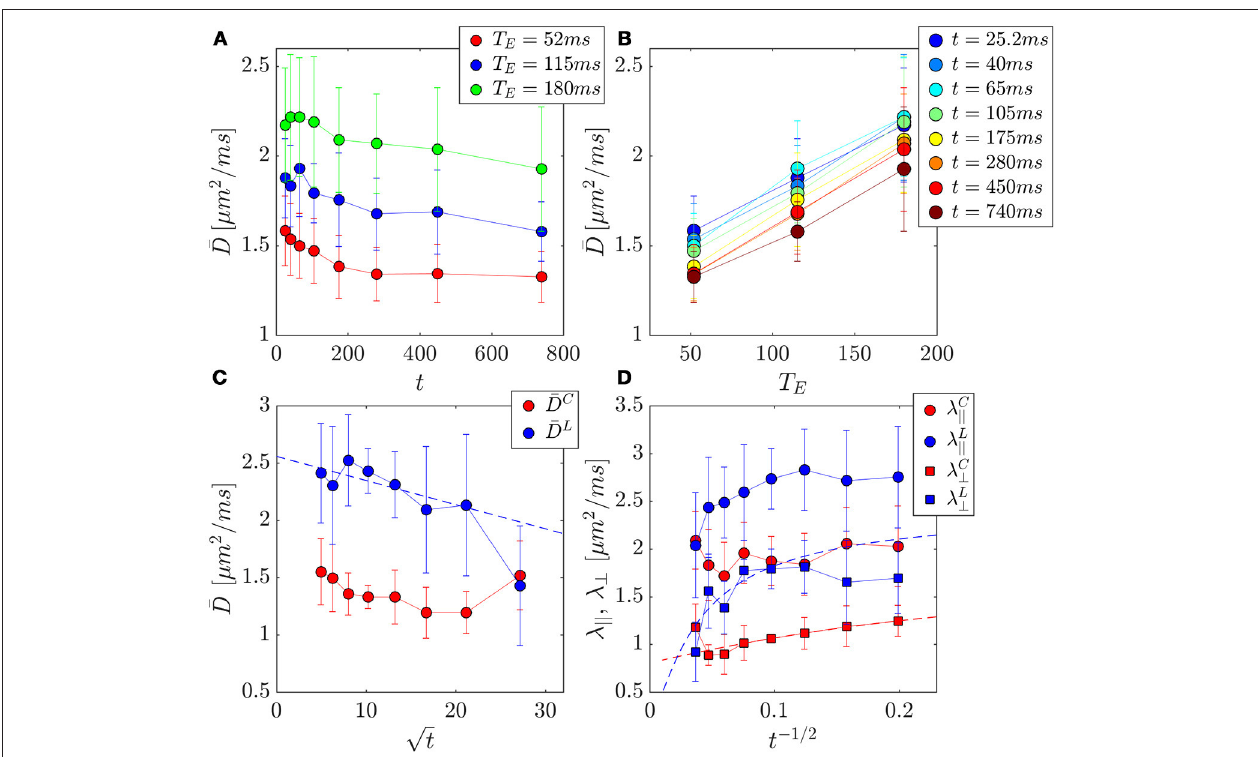
FIGURE 6 | PZ ROI separation of prostate tissue diffusivities (A,B) into compartment contributions (C,D) in 3 healthy volunteers. Error bars indicate variance between subjects. (A) The change in the mean diffusivity, D , with t was as much as change of 59% over this parameter. (C) Mean diffusivities from the cellular and luminal compartments plotted against √ t , where a linear dependence be the hallmark ∼ of the short-time S / V limit. (D) Axial and radial compartment diffusivities, λ disorder universality class of random membranes, and justify the usage of the RPBM for calculating length scales and